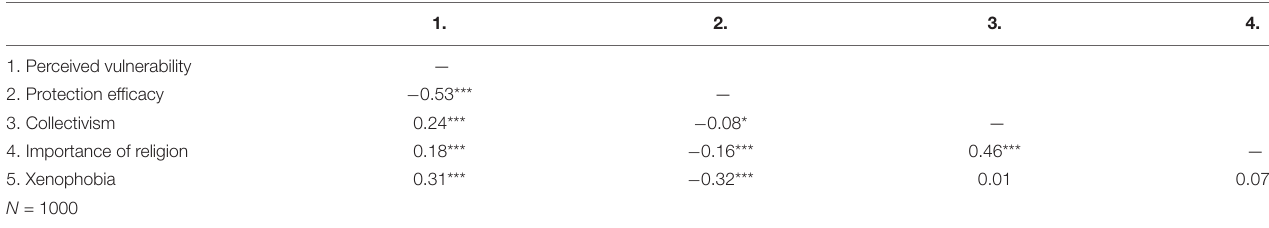
TABLE 2 | Partial correlations among vulnerability, efficacy, collectivism, importance of religion, and xenophobia with political ideology, age, gender, education and income as